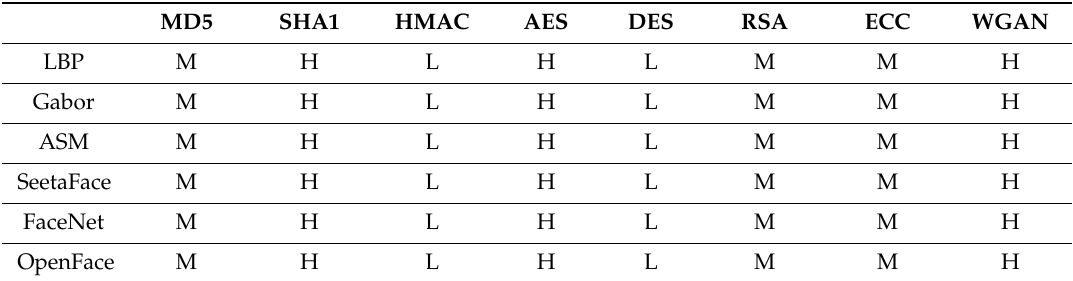
Table 2. Sensitivity analysis of keys (L, Low; M, Medium; H,